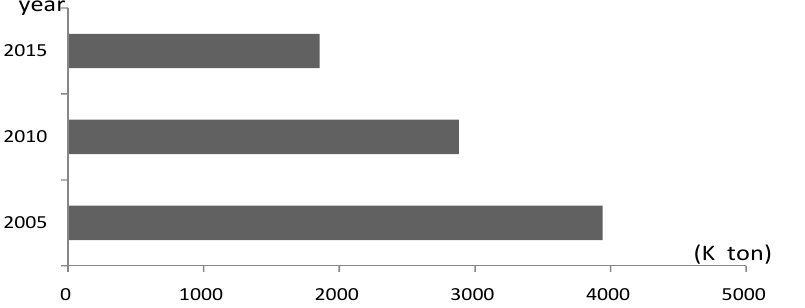
Figure 1. Total chemical oxygen demand (COD) discharge in industrial sewage of top 10 water-intensive industries in China. Data sources: China Environmental Statistical Yearbook (2005–2015).